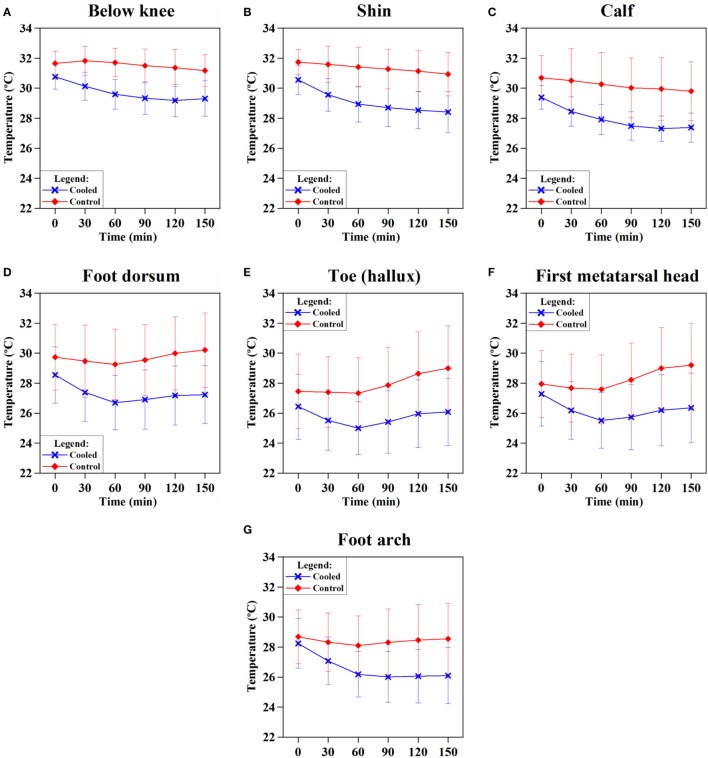
Trend of skin temperature of the cooled (blue) vs. control (red) leg over the duration of limb hypothermia in breast cancer patients. Skin temperature was acquired continuously at various sensor locations: (A) below knee, (B) at the shin, (C) calf, (D) dorsum of the foot, (E) toe (hallux), (F) first metatarsal head, and (G) foot arch (foot plantar). Skin temperatures of the cooled leg showed significantly lower temperatures than the control leg at each time point (p < 0.05). Limb hypothermia was administered at a coolant temperature of 22°C throughout the duration of chemotherapy.